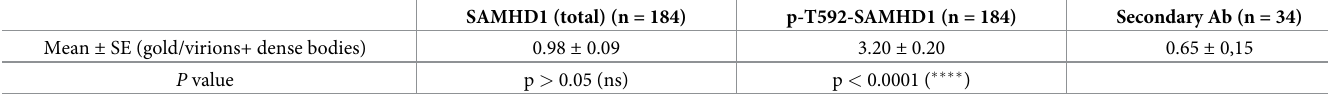
Table 2. Immunogold quantification of total and pT592-SAMHD1 on virions and dense bodies in infected cells (MOI 1).